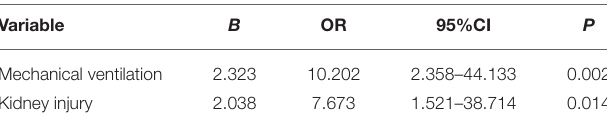
TABLE 8 | Multivariate analysis of elevated pancreatic enzymes in COVID-19 patients ( n = 52). Variable B OR 95%CI P Mechanical ventilation 2.323 10.202 2.358–44.133 0.002 Kidney injury 2.038 7.673 1.521–38.714